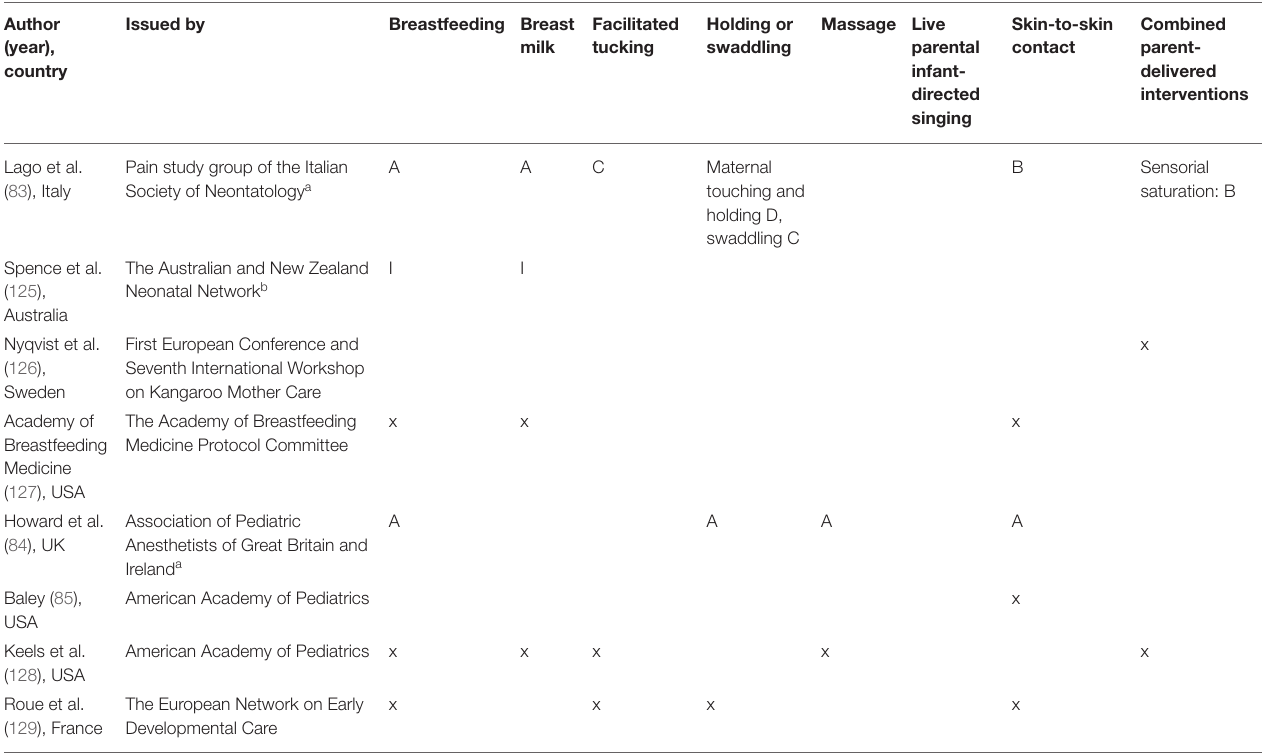
TABLE 9 | Recommendations in clinical